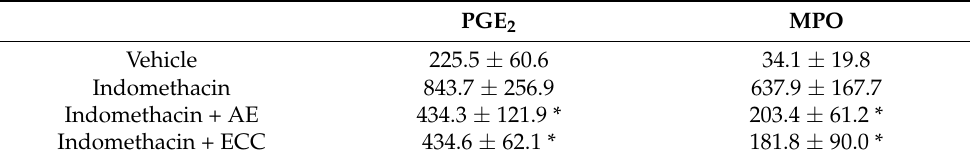
Figure 10. Effects of ECC on inflammatory protein expressions in rat stomachs. Forty rats were fasted for 48 h before the experiment. Experimental groups were treated with Cinnamomum cassia extract (CE, 24 mg/kg) or Artemisia extract (AE, 20 mg/kg) for 30 min and then with indomethacin (80 mg/kg). All treatments were administrated orally. Five hours later, all animals were sacrificed, and their stomachs were harvested to measure the inflammatory regulators using Western blotting. ( A ) Representative pictures of Western blotting. ( B ) Statistical result. The data represent values from 3 repeated experiments. * p < 0.05 compared to the indomethacin group. Table 1. Effects of ECC on serum PGE2 and MPO.